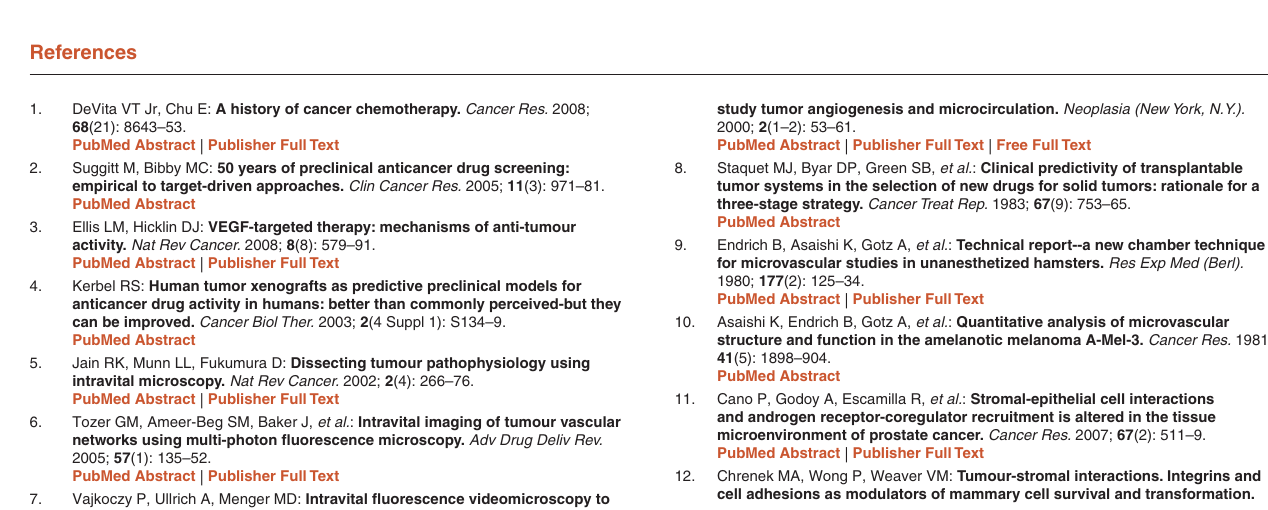
Effect of orthotopic tissue co-implantation on TRAMP C2 and MOVCAR-16 tumor